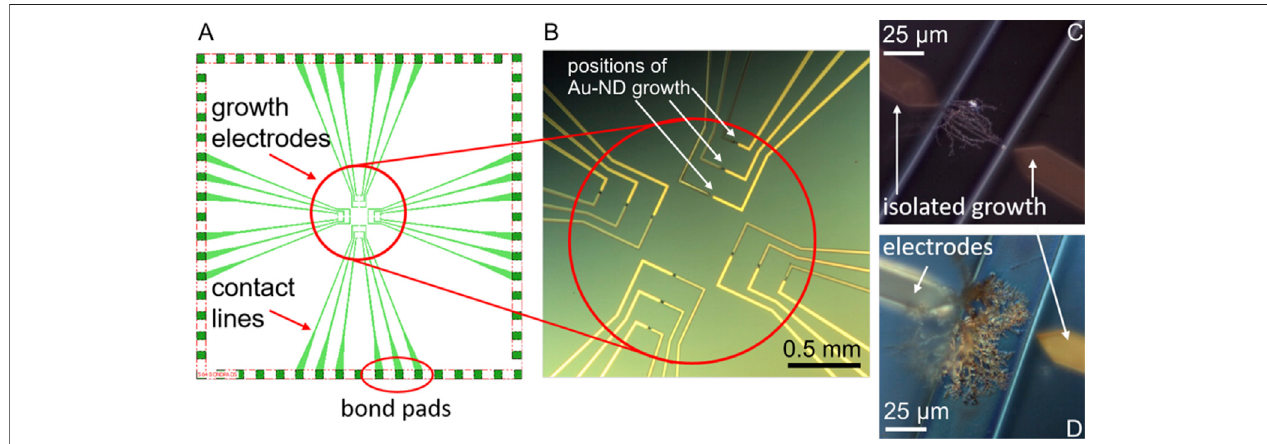
FIGURE 1 | The chip design (not scaled) (A) and optical microscopy image (B) of the electrochemical system with the AuND electrode growth area (circled in red), white arrows show examples of the growth positions of the AuND. Examples of the AuND electrodes after isolation (C,D) . The electrode gap between the growth electrodes is 50